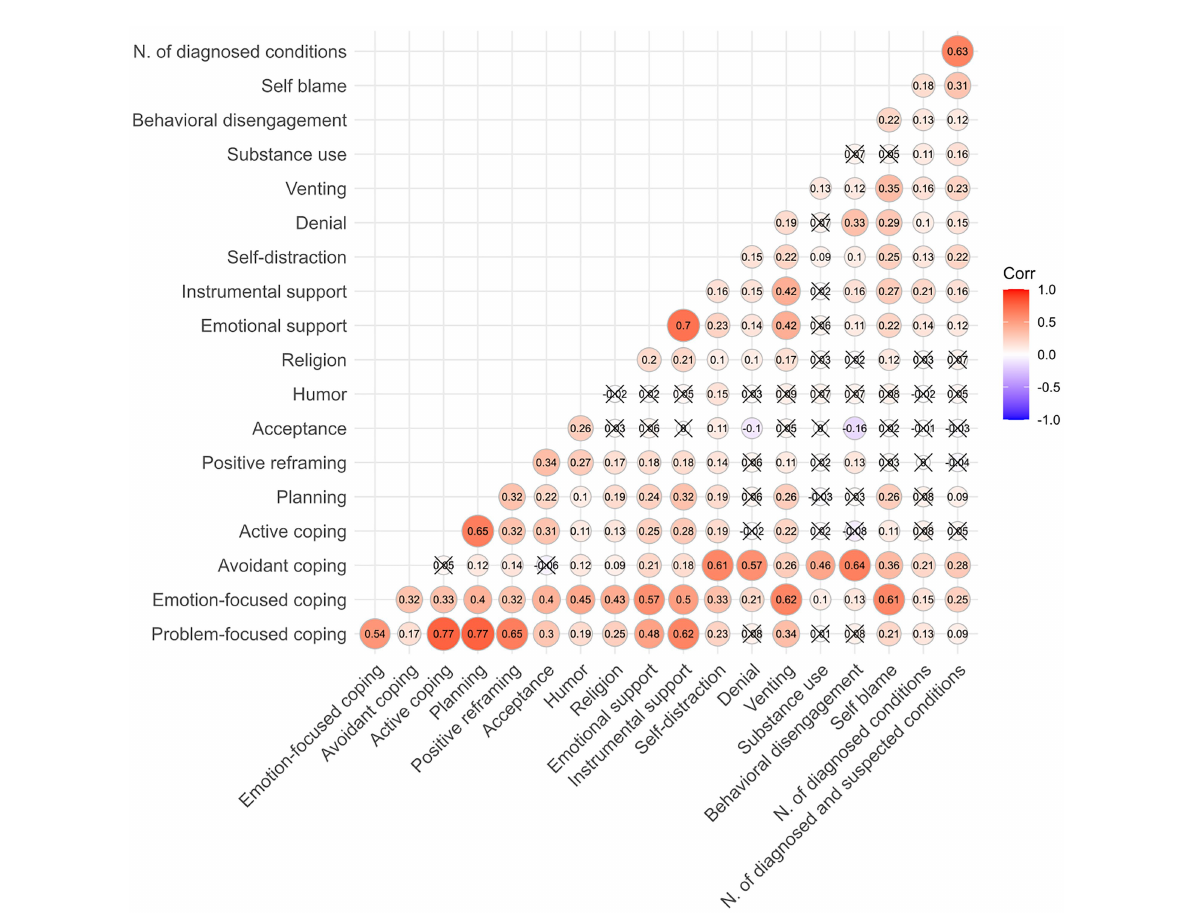
FIGURE 2 Correlation heatmap for bivariate Spearman correlations of the number of physiological and psychological overexcitabilities and coping strategies assessed using the Brief